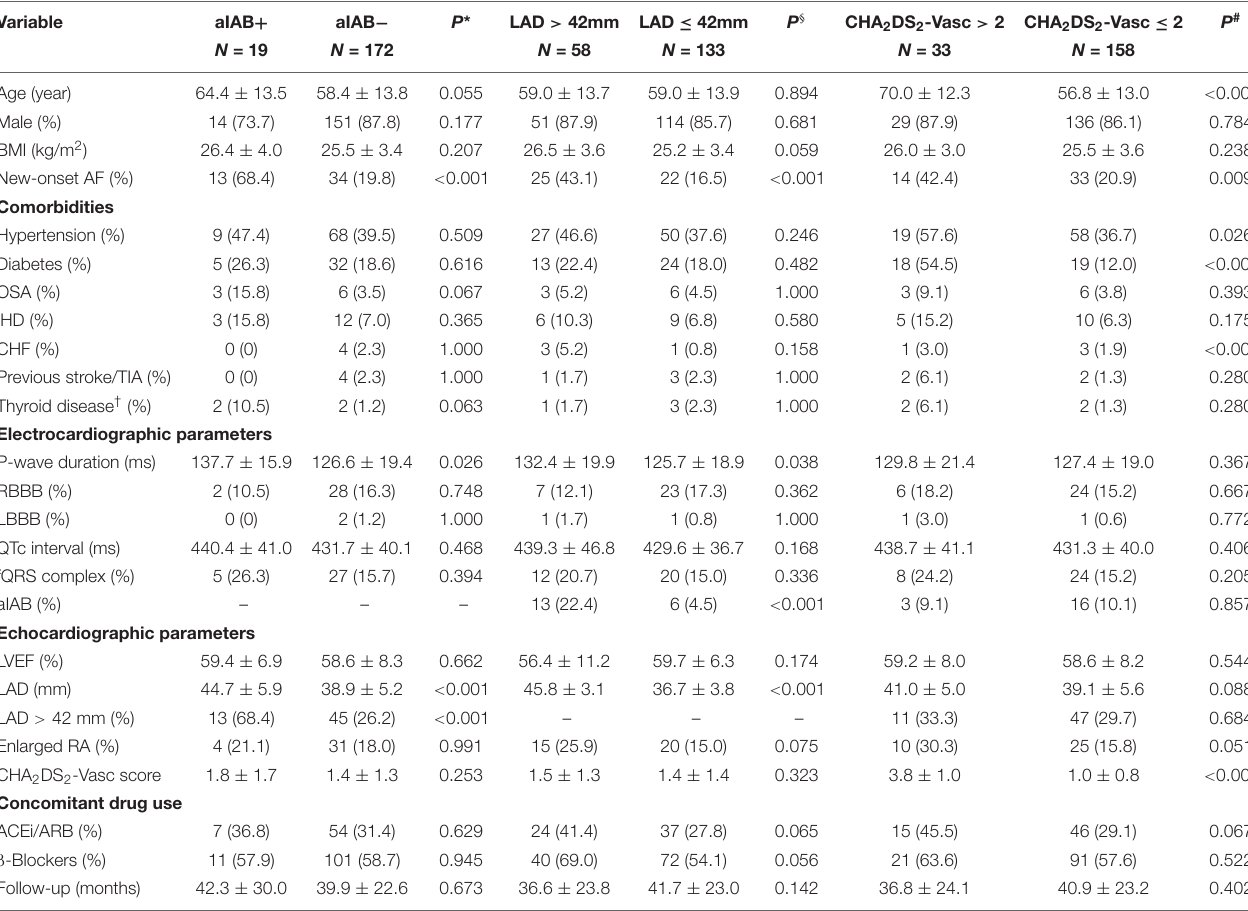
TABLE 2 | Comparison between patients grouped by aIAB, LAD, and CHA 2 DS 2 -Vasc score.